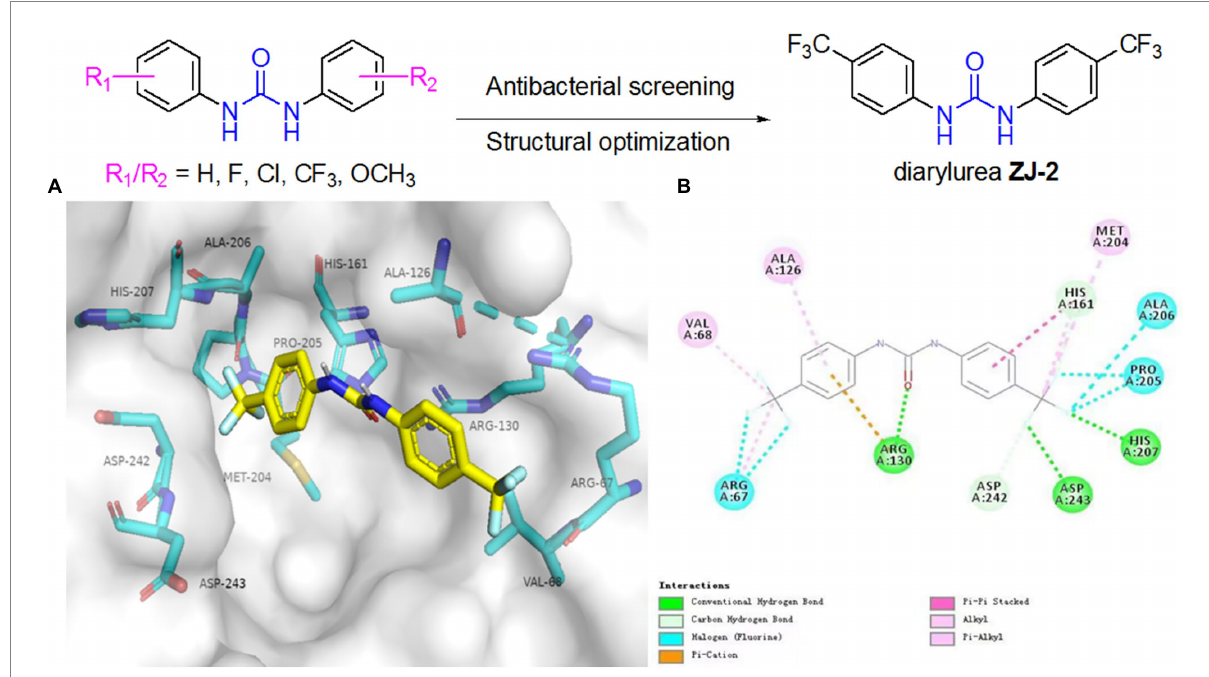
FIGURE 2 (A) Binding modes of ZJ-2 with SagA (PDB code: 2OXN). (B) 2D mode of the interaction of ZJ-2 with receptor SagA. Hydrogen bonds are shown in green, p – p interactions are shown in purple, halogen bonds are shown in blue and p -cation bond is shown in